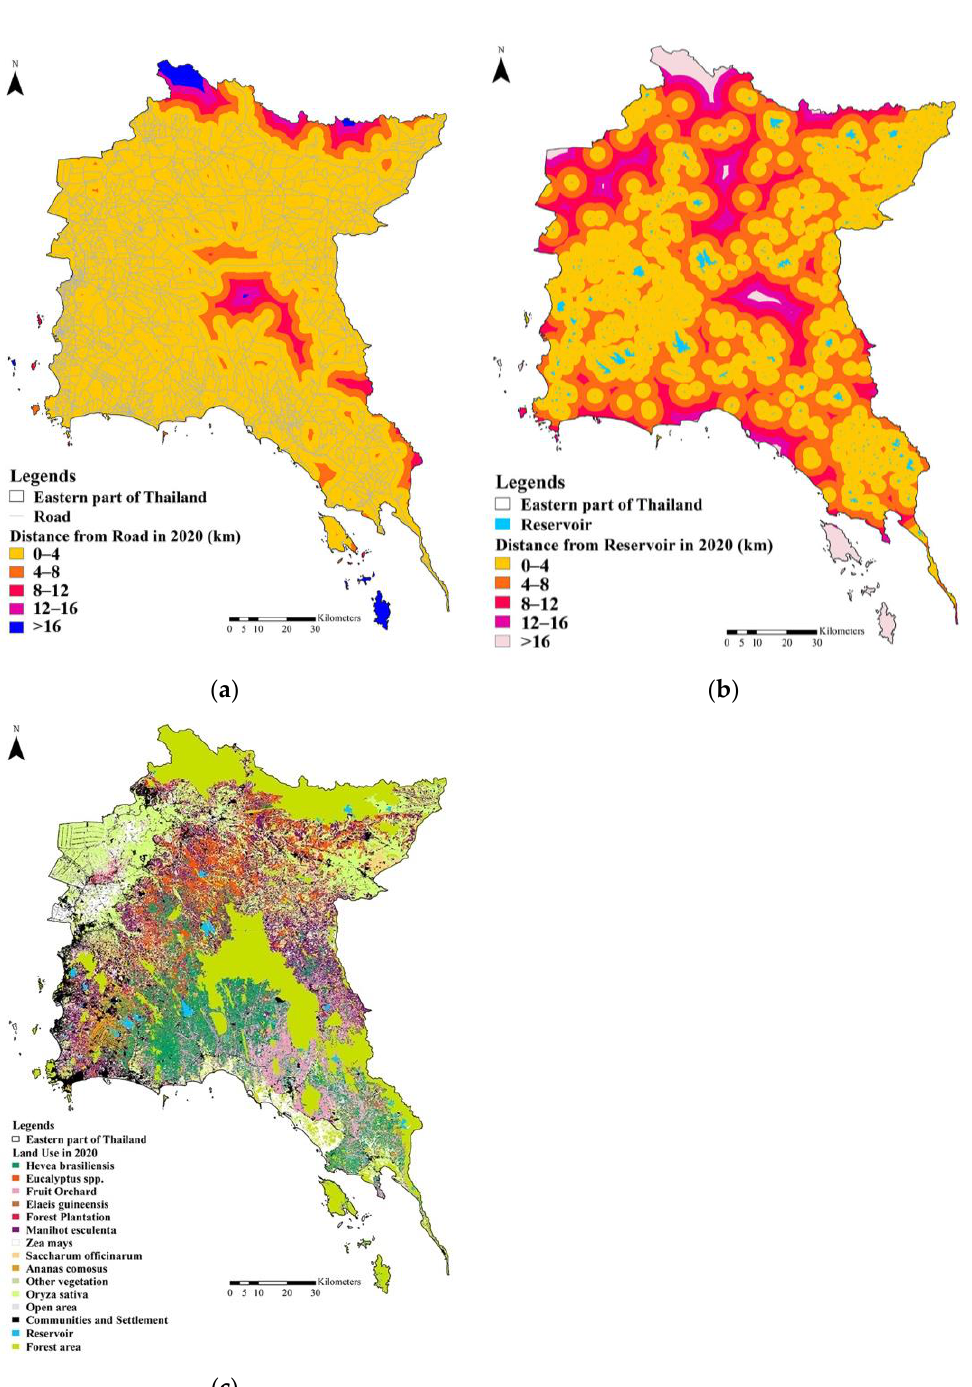
Figure 2. Land use of the eastern part of Thailand in 2020: ( a ) road, ( b ) reservoir, and ( c ) agricul- tural area.